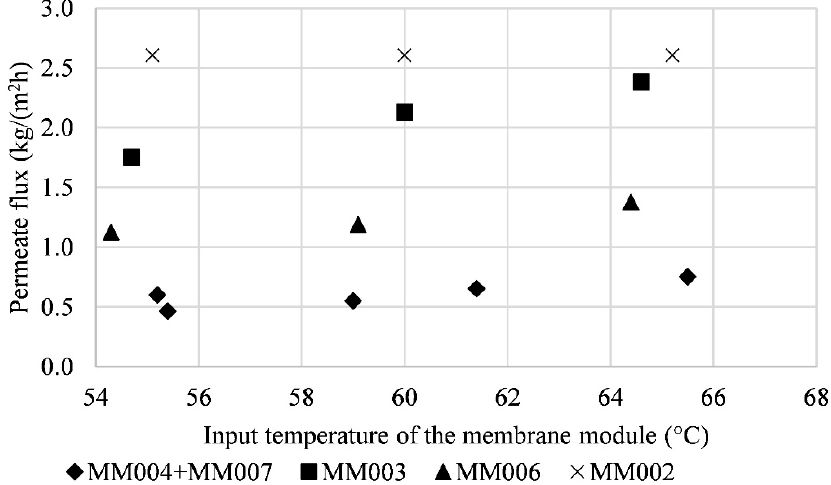
Figure 8. The comparison of the permeate flux depending on the input temperature of the membrane module.